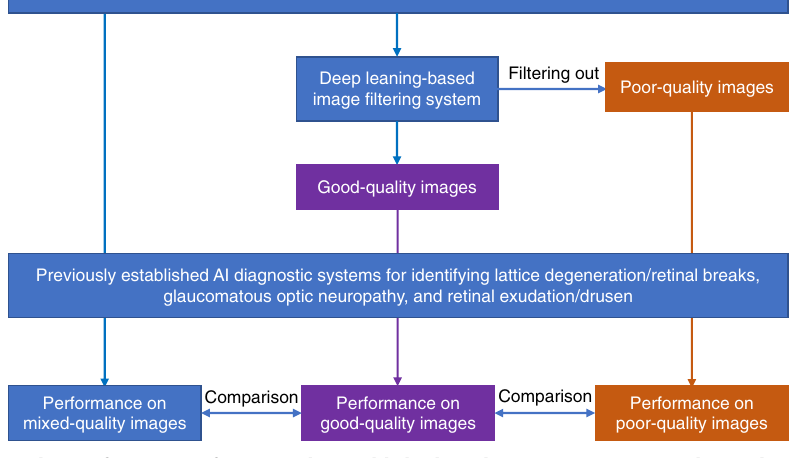
Fig. 7 Flowchart evaluating the performance of previously established AI diagnostic systems with good-quality (with DLIFS), mixed- quality (without DLIFS), and poor-quality ultra-wide fi eld images. AI arti fi cial intelligence, DLIFS deep learning-based image fi ltering